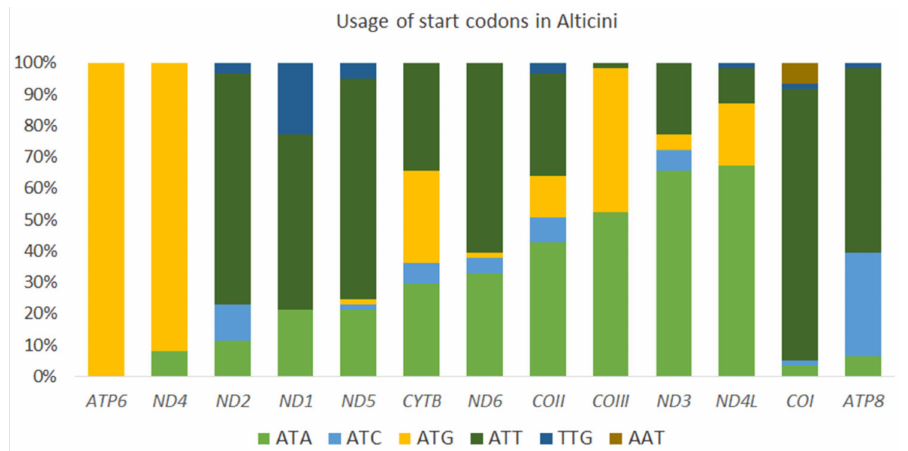
Figure 6. Usage of start codons found in the complete set of mitochondrial protein-coding genes in 64 species in the tribe Alticini (Coleoptera: